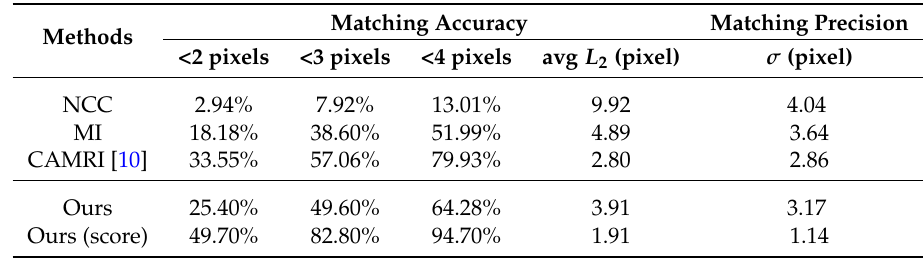
Table 1. Comparison of the matching accuracy and precision of our method with accuracies of normalized cross-correlation (NCC), mutual information (MI) and CAMRI [10] over the test set. The matching accuracy is measured as the percentage of matching points, having a L 2 distance to the ground truth location smaller than a specific number of pixels and as the average over the L 2 distances between the predicted matching points and the ground truth locations (measured in pixel units). The matching precision is represented by the standard deviation σ (measured in pixel